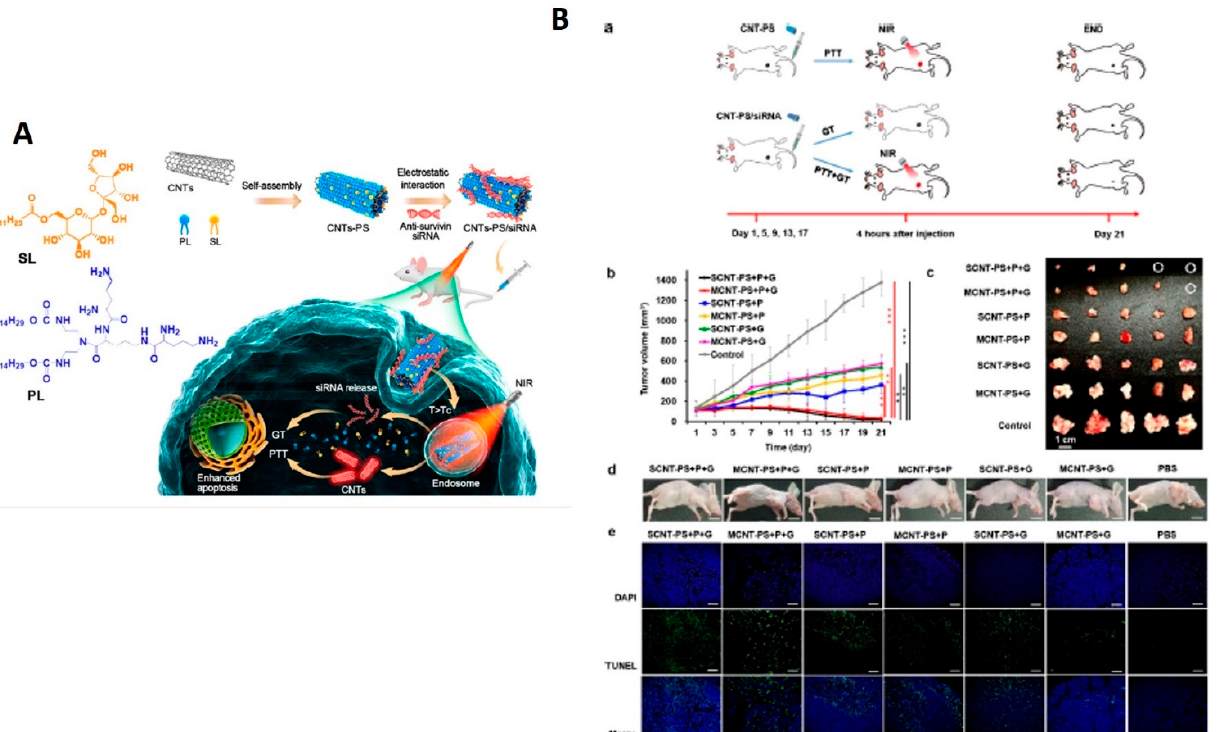
Figure 11. ( A ) Schematic diagram of the temperature-sensitive CNT-PS/siRNA nanoparticle for the synergistic PTT and GT of cancer cells. ( B ) In vivo anti-tumor study. ( a ) Treatment